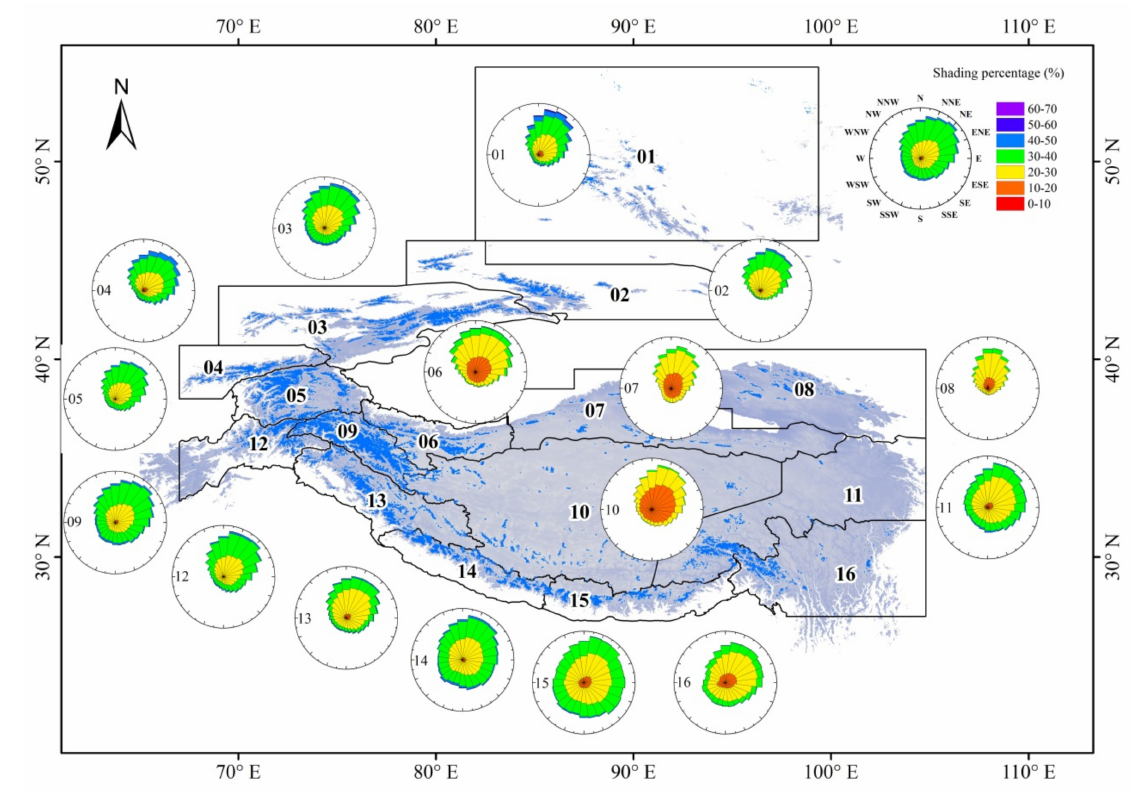
Figure 8. Distribution of shading on different aspects for each region within